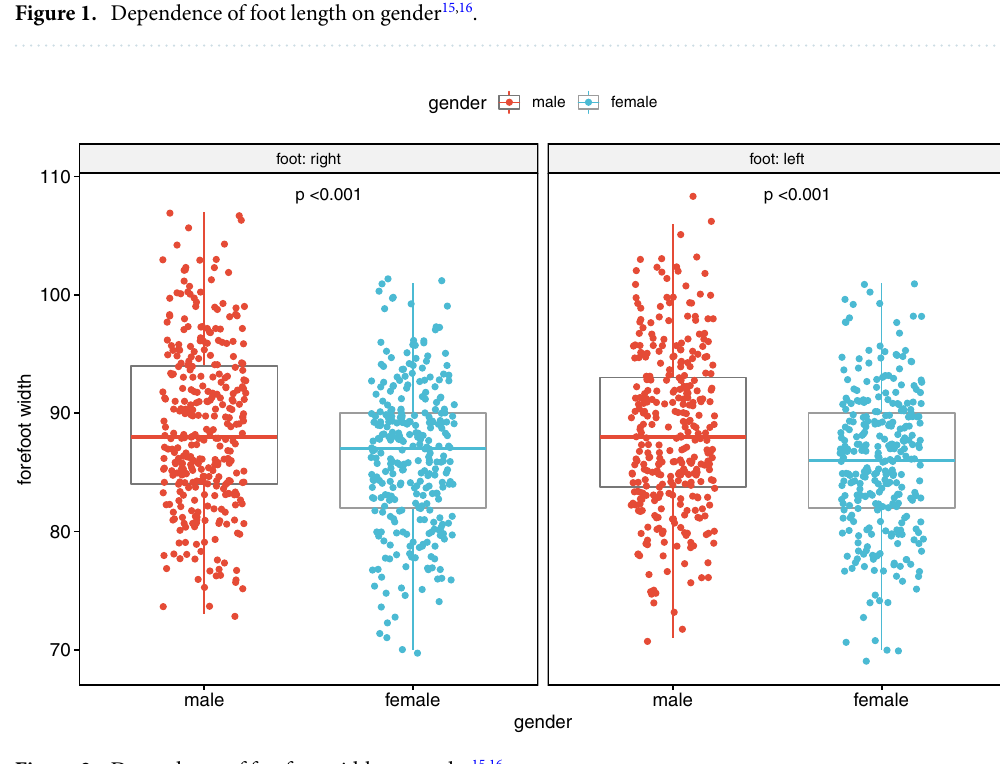
Figure 2. Dependence of forefoot width on gender 15,16